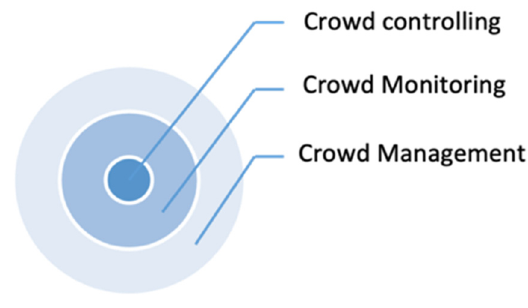
Figure 1. Crowd analysis